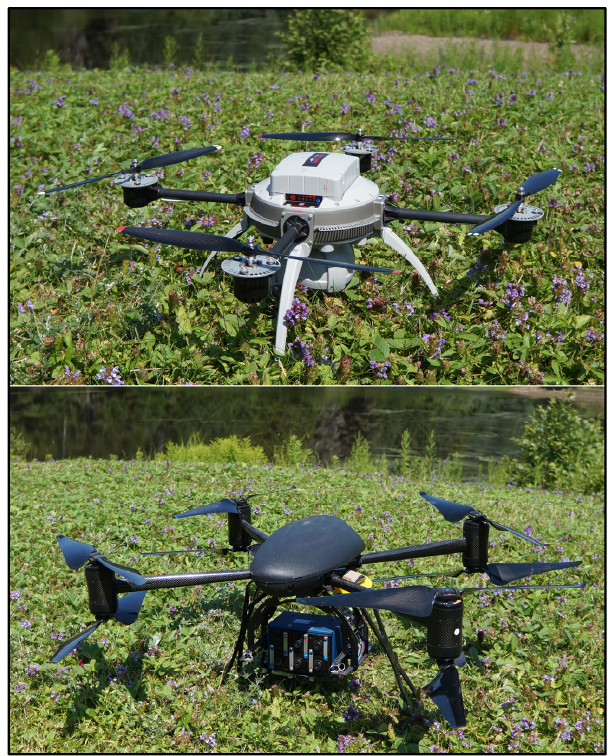
Figure 5. Two unmanned arial system (UAS) quadrocopters deployed by Nipissing University researchers for agricultural monitoring. The Aeryon Scout (Aeryon Labs Inc., Waterloo, ON, Canada) carries (top photo) an infrared ADC lite camera (Tetracam, Chatsworth, CA, USA), whereas the Dragan Flyer X ‐ 8 (Draganfly Innovations Inc., Saskatoon, SK, Canada) carries a Mini ‐ MCA camera (Tetracam, Chatsworth, CA, USA).